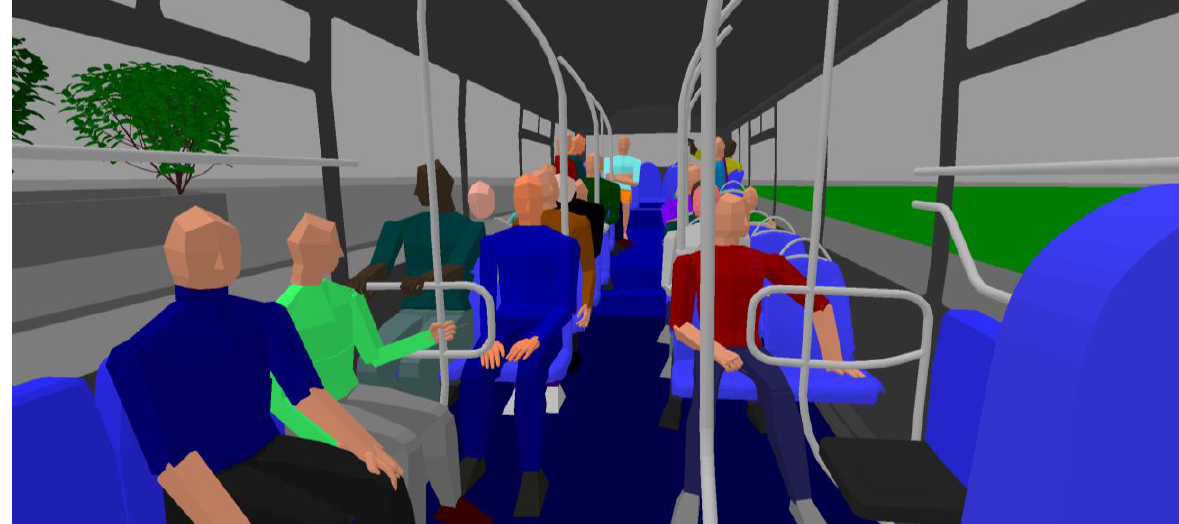
Figure 5. Bus interior modelled and populated in the SAMMIE DHM